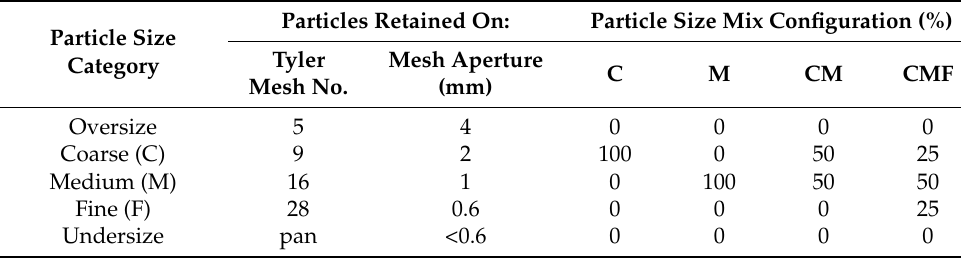
Figure 2. Particle size categories of hemp hurd furnish considered for the panel manufacture: fine ( ≥ 0.6 to 1 mm) ( a ), medium ( ≥ 1 to 2 mm) ( b ) and coarse ( ≥ 2 to 4 mm) ( c ). Table 2. Particle size categories and proportions in the panel variants.